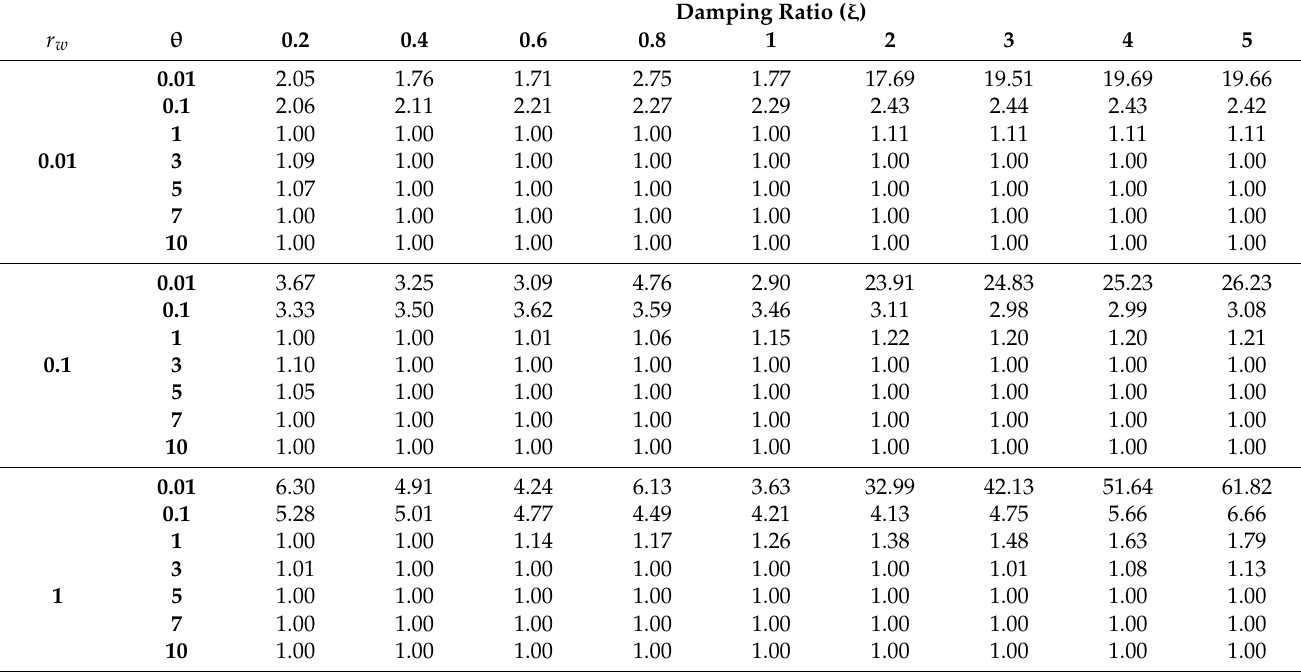
Table 7. Normalized IAE for MPC (Process 2, Disturbance